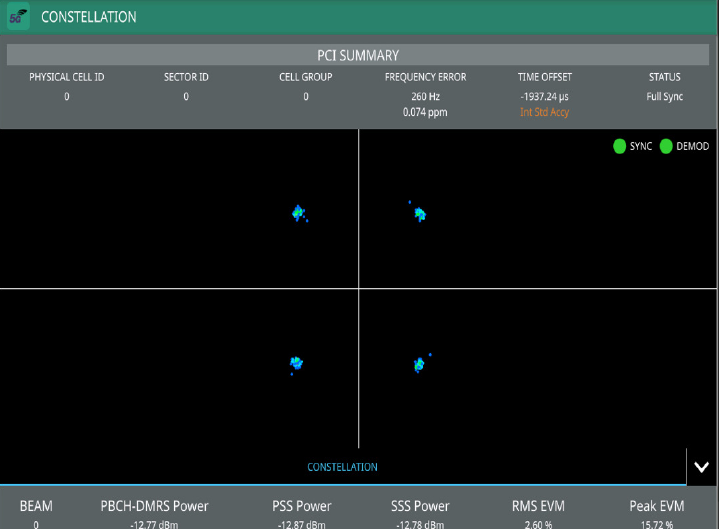
Figure 5. Q-PSK modulation scheme representation of the PBCH in the gnodeB measured through the